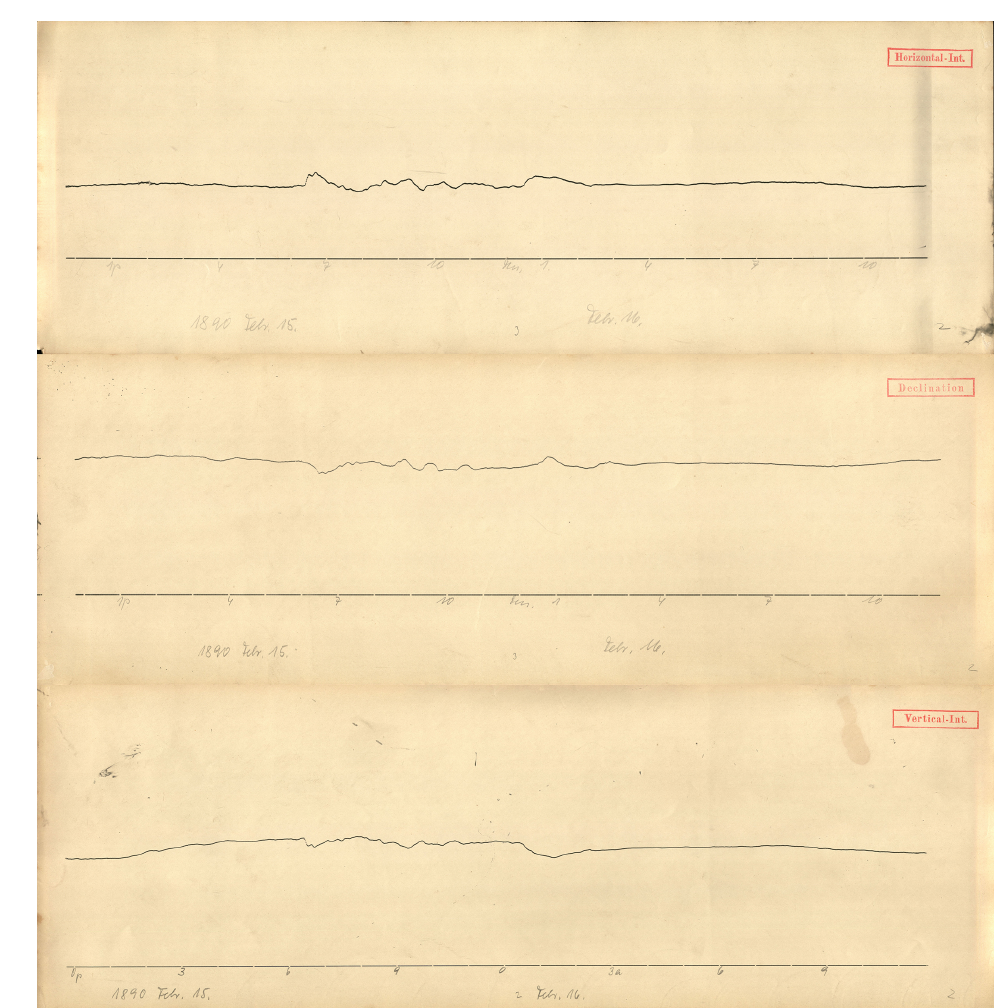
Figure 9. Potsdam Observatory photographic recordings of the declination and horizontal and vertical intensity of the time interval 15 Febru- ary 1890 12:00 till 16 February 1890 12:00 (Potsdam mean local time). Source: Helmholtz Centre Potsdam – GFZ.